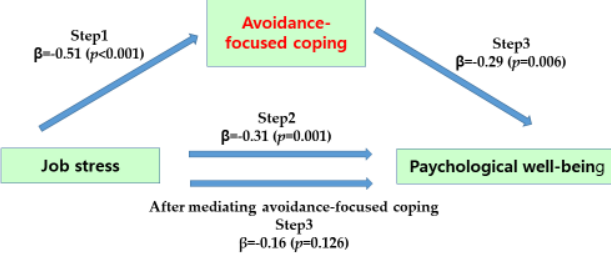
Figure 3. Mediating effect of avoidance-focused coping of Figure 3 . Mediating effect of avoidance-focused coping of participants .